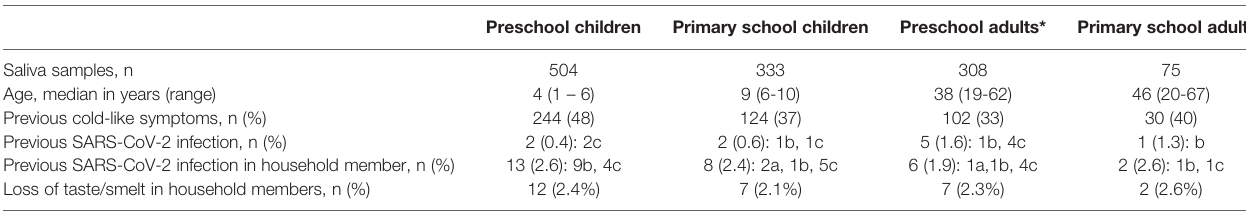
TABLE 3 | Characteristics of the study populations.